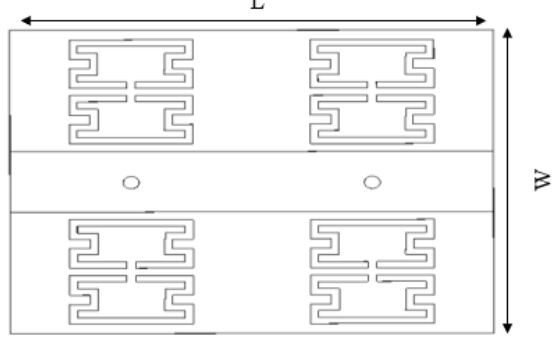
FIGURE. 5. TOP VIEW OF MOORE FRACTAL APPLIED SYMMETRICAL RING RESONATOR BANDPASS